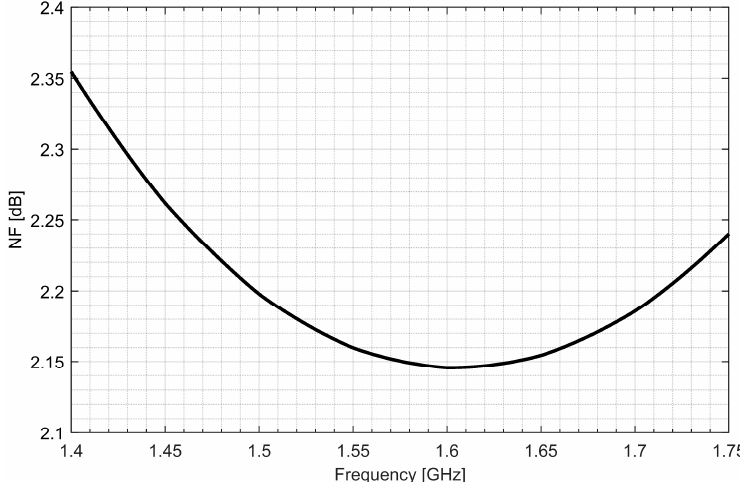
Figure 6. Noise figure characteristics of the L1/E1 low-noise amplifier.